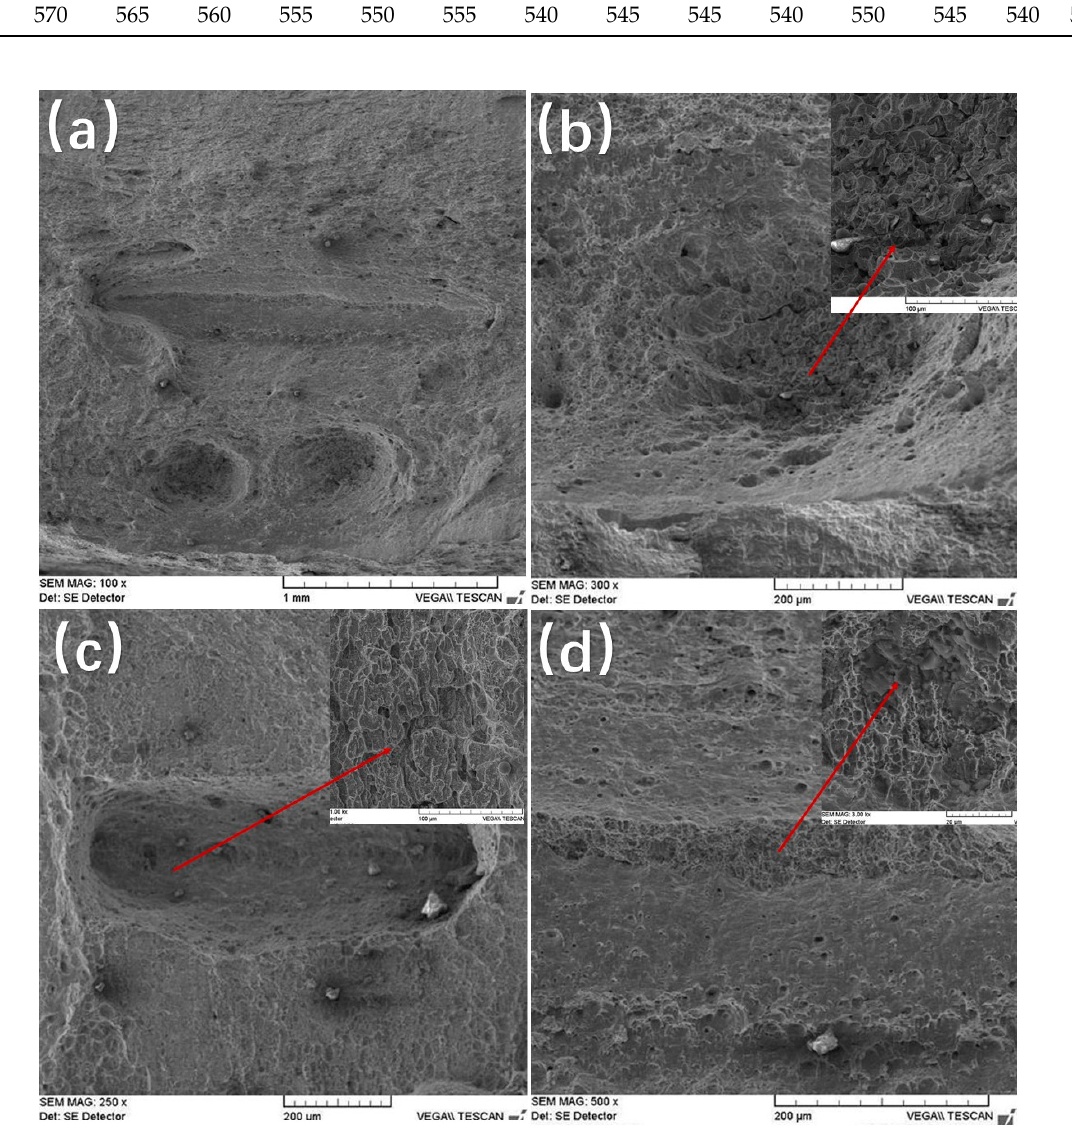
Figure 14. SEM morphology of tensile fracture: ( a ) “Gray spot” (bottom) and separation (top) of 1# cracking pipe welds; ( b , c ) “gray spot” of 2# cracking pipe welds; ( d ) fracture separation of 2# cracking pipe weld.